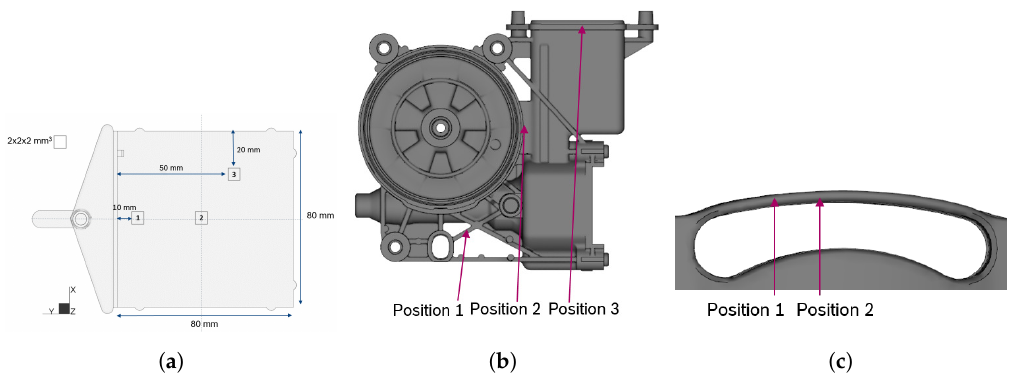
Figure 13. Different geometries with the position of the µ CT scans. ( a ) Plate. ( b ) Window lift drive housing. ( c ) Sensor cover (partly